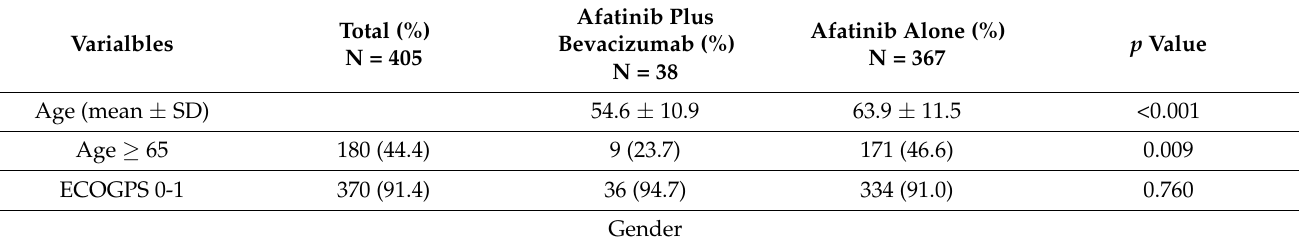
Table 1. Overall patient